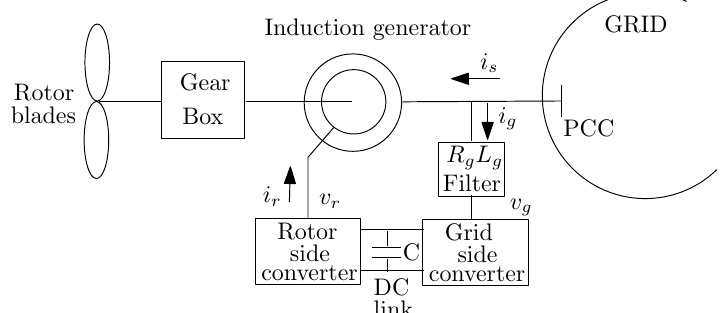
Figure 3. Schematic diagram of the wind turbine generator (WTG) connected to the